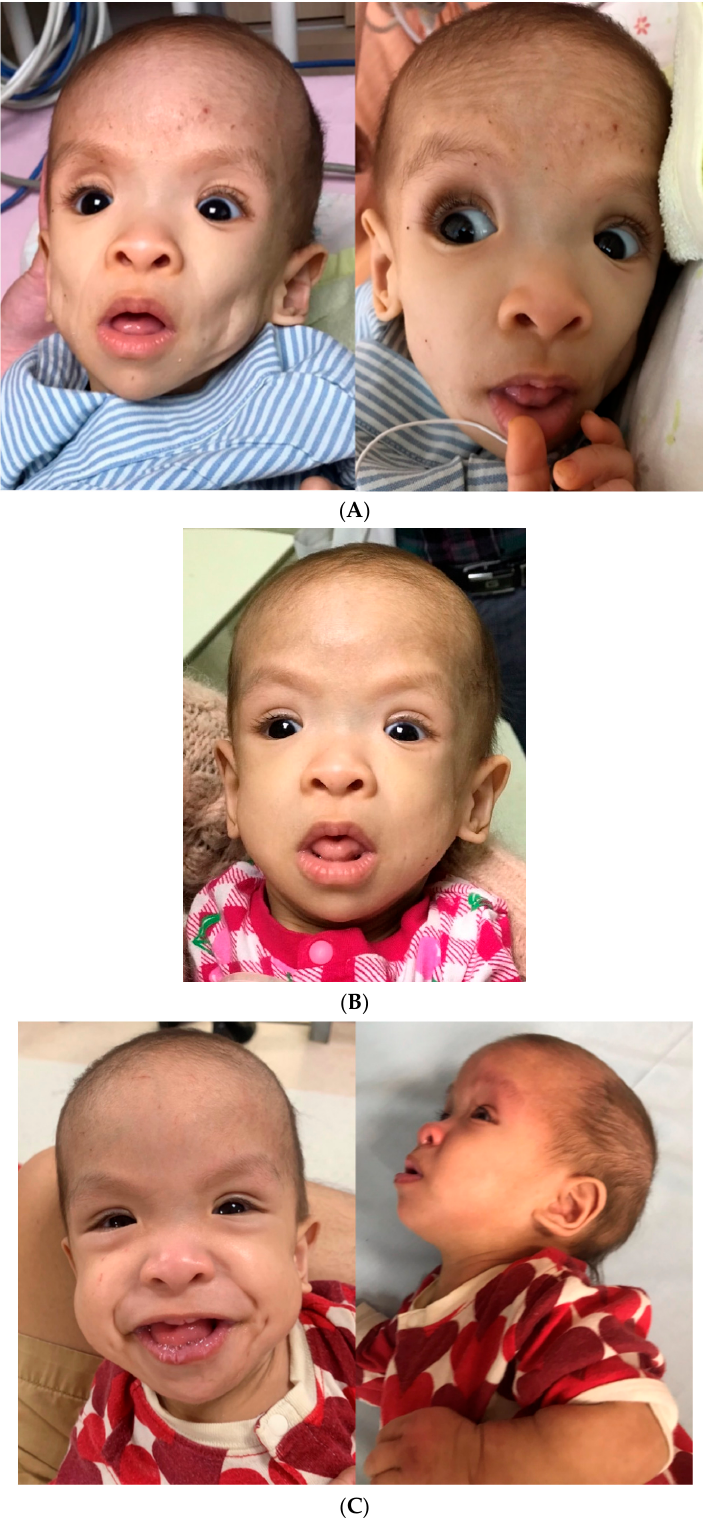
Figure 2. Craniofacial features of the patient. ( A ) At the age of one year, with a body weight of 3.6 kg. ( B ) At the age of one year and five months, with a body weight of 4.7 kg. Low nasal bridge and thick lips were more distinct. ( C ) At the age of one year and six months, with a body weight of 7.4 kg. Downslanting eyes, low nasal bridge, thick lips, wide nostrils and curly, sparse, thin hair were